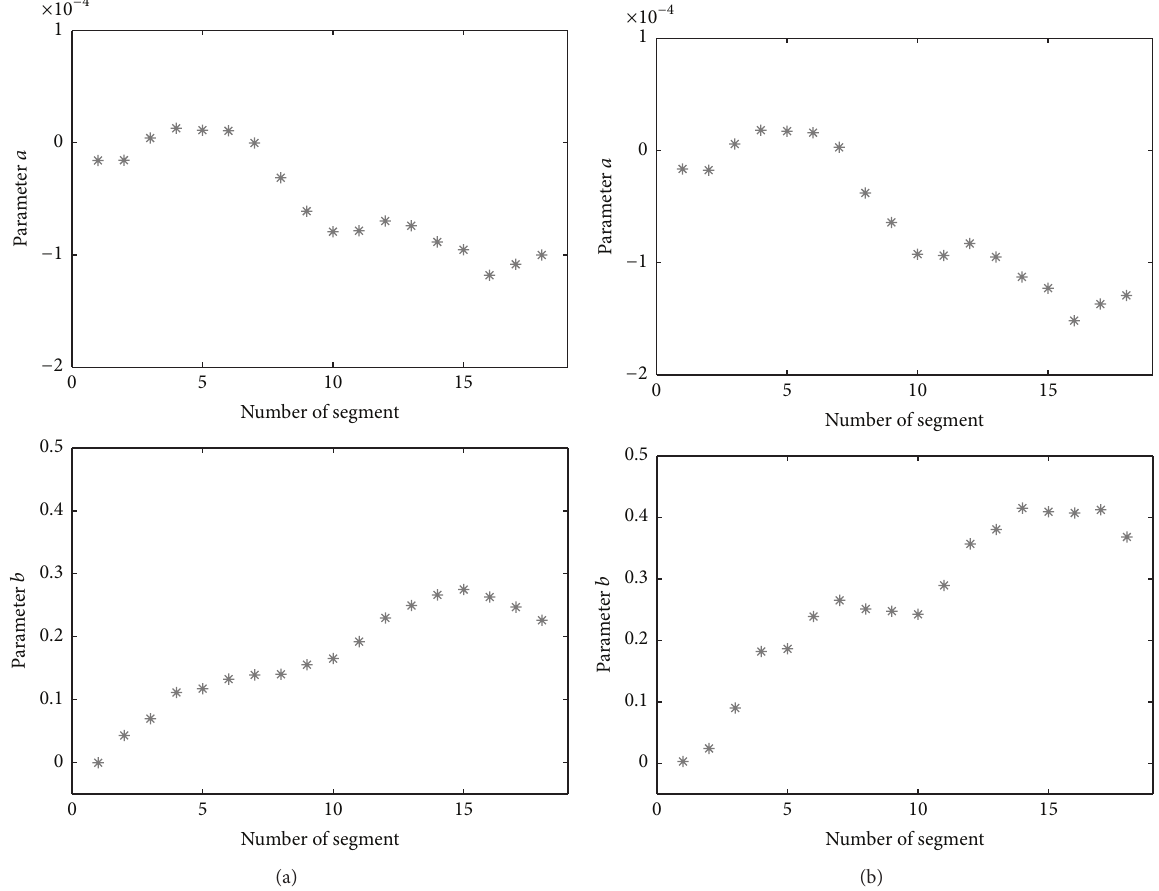
Figure 9: Fluctuation of parameters 𝑎 and 𝑏 obtained for consecutive segments of estimation error on PP over power (a) and rotational speed